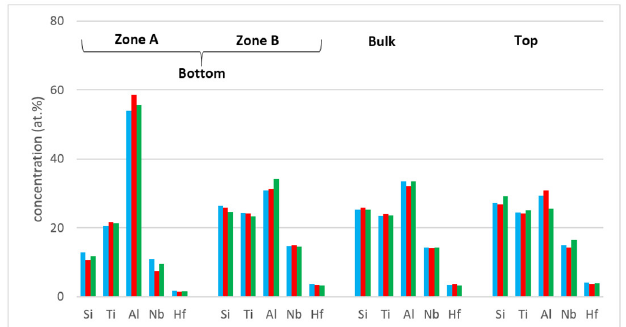
Figure 5. Comparison of the concentrations of elements in the bottom, bulk and top of the alloy Nb 1.3 Si 2.4 Ti 2.4 Al 3.5 Hf 0.4 . As cast-blue bars, heat treated at 800 °C—red bars and heat treated at 1200 °C— green bars.